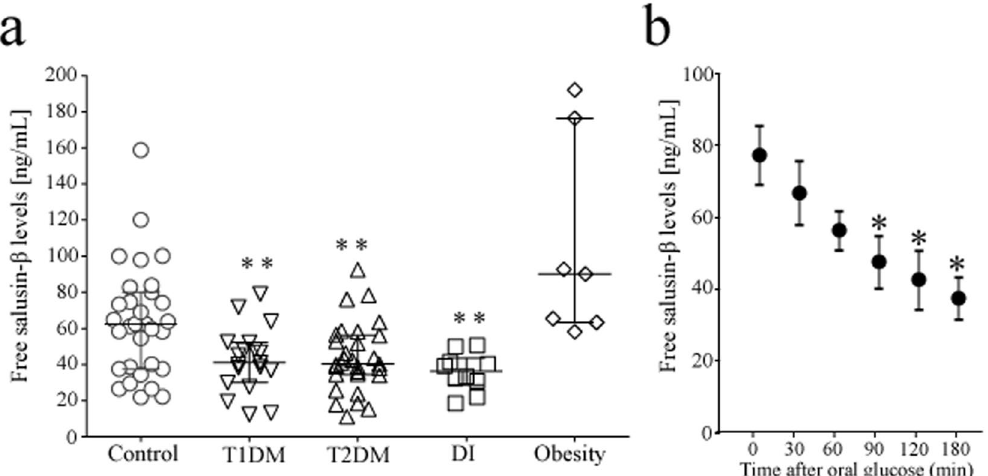
Figure 3. Plasma salusin- β concentrations in healthy non-obese and obese subjects and in patients with diabetes mellitus and diabetes insipidus. ( a ) Plasma free salusin- β levels were determined in 20 patients with type 1 diabetes (T1DM, 11 males and 9 females), 31 patients with type 2 diabetes (T2DM, 15 males and 16 females), and 10 patients with panhypopituitarism and complete central diabetes insipidus (DI, 4 males and 6 females) and in 7 non-diabetic subjects with obesity (4 males and 3 females) and compared with the levels of 28 healthy non-obese subjects (14 males and 14 females). Each point represents the salusin- β level found in a single subject and the horizontal bars indicate the median and whiskers extending between the 25 th and 75 th percentile values of each group. A one-way ANOVA followed by a Mann-Whitney U post hoc test was used to compare free salusin- β levels for each pair of groups. ** P < 0.005, compared against the control group. b. Blood samples were collected from ten non-diabetic subjects before and at 30, 60, 90, 120 and 180 min after oral ingestion of 75 g glucose. Plasma glucose, immunoreactive insulin and free salusin- β levels were measured. Data points with bars represent mean ± SE. * P < 0.05, compared against the baseline